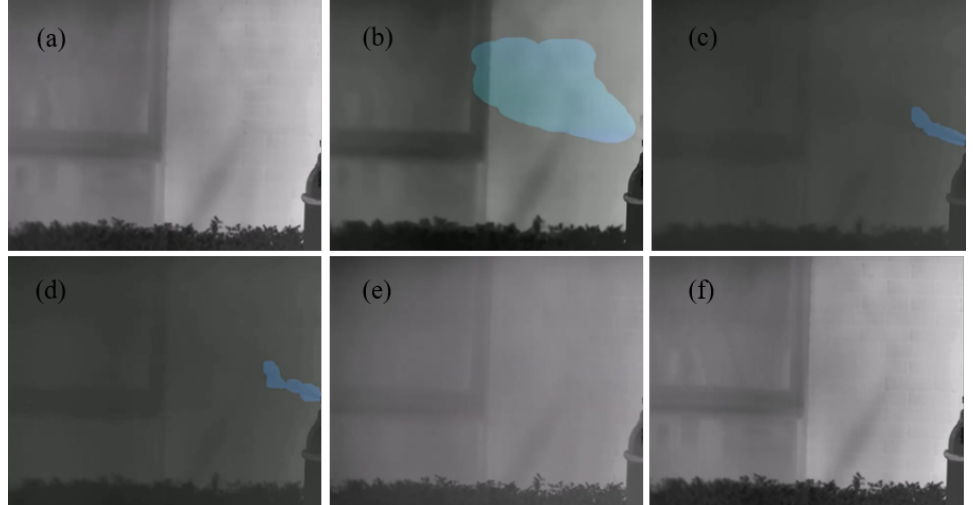
Figure 13. The imaging processing results of ( a ) LP2000 ( b ) LP3750 ( c ) LP4750 ( d ) LP6360 ( e ) LP9000 ( f ) LP10150 of carbon